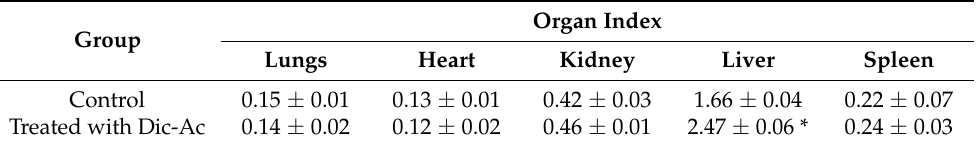
Table 3. Organs absolute mass of control and treated with Dic-Ac groups in the acute toxicity experiment (2000 mg kg − 1 ).